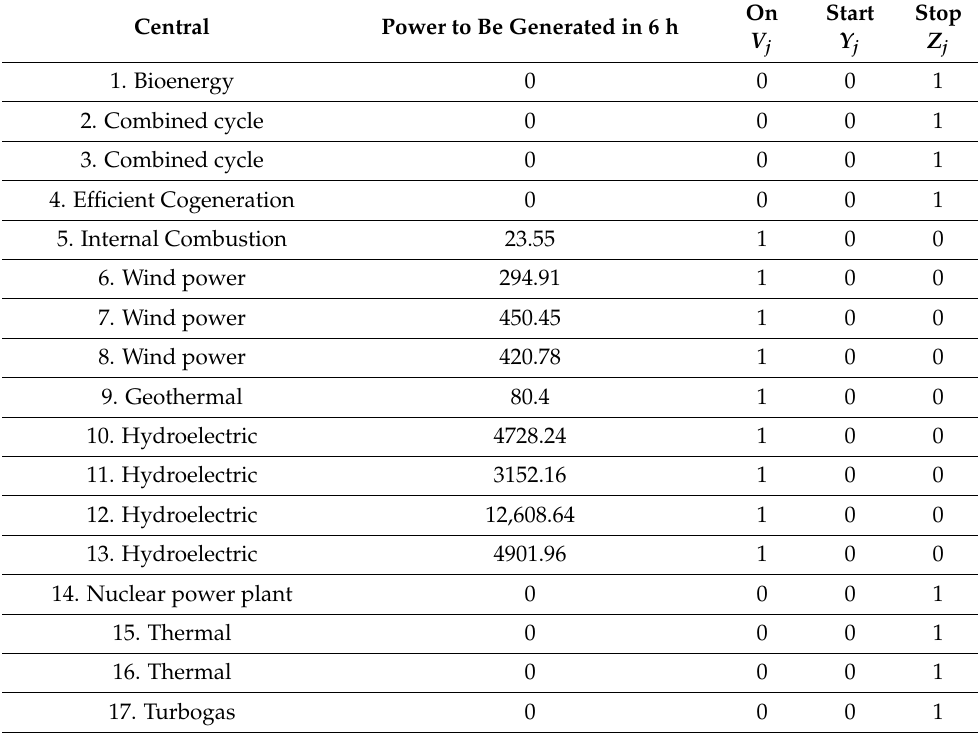
Table 5. Results of period 3. Central Power to Be Generated in 6 h